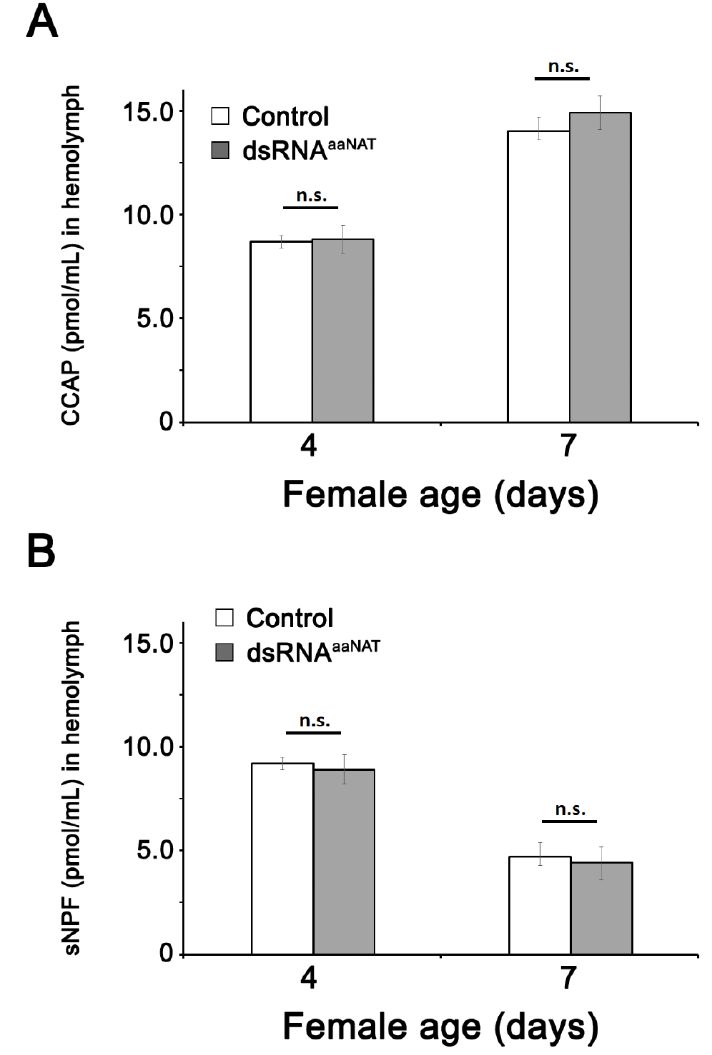
Figure 2. Concentrations of hemolymph crustacean cardioactive peptide (CCAP) ( A ) and short neuropeptide F (sNPF) ( B ) 4- and 7-days post-injection of P. americana adult females with dsRNA aaNAT . Data is displayed as mean ± SEM, ( n = 25 individuals/condition). n.s., no statistically significant differences were observed between the tested groups using the Student’s t -test.